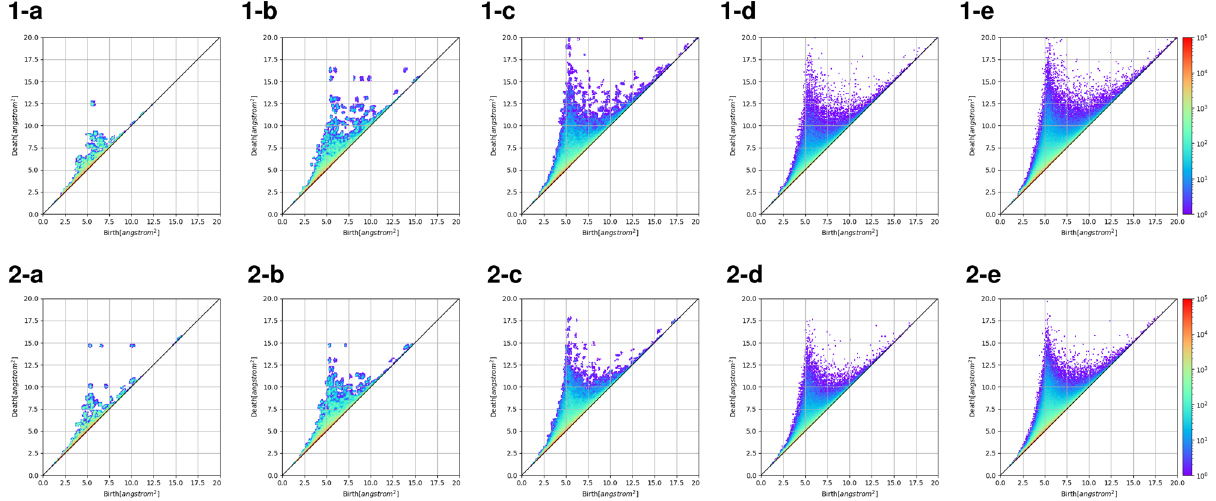
Figure 4. The change in the 2nd-order persistent diagrams with a hydrogen coordinate in each simulated cell size (2 nm to 30 nm). (a) 2 nm expand to 20 nm , (b) 4 nm expand to 20 nm, (c) 10 nm expand to 30 nm, (d) 20 nm, (e) 30 nm. Line1 is 150 K in sample 1. Line 2 is 450 K in sample